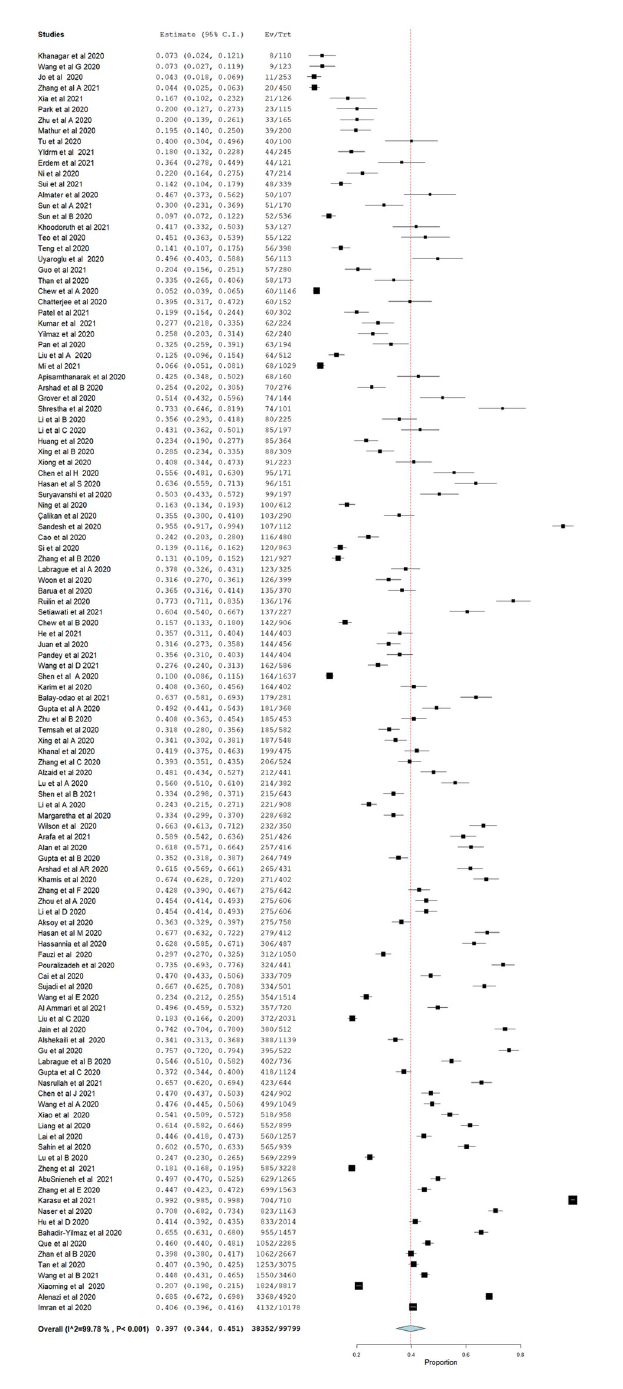
Fig 3. Forest plot of overall pooled prevalence of